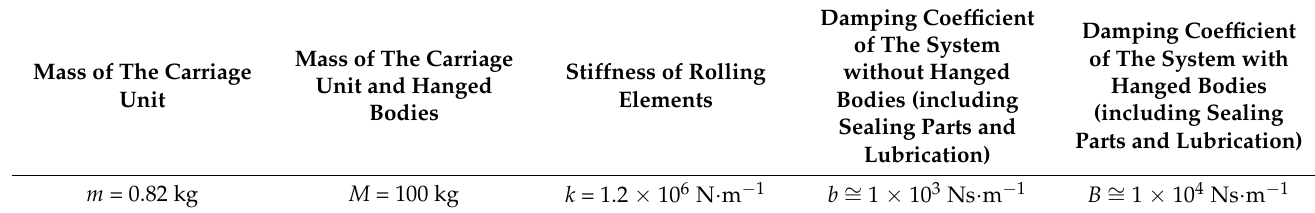
Figure 16. The simplified mechanical model. Table 3 summarises the dynamical parameters of the simplified mechanical model. Table 3. Dynamical parameters of the simplified mechanical model in Figure 16.